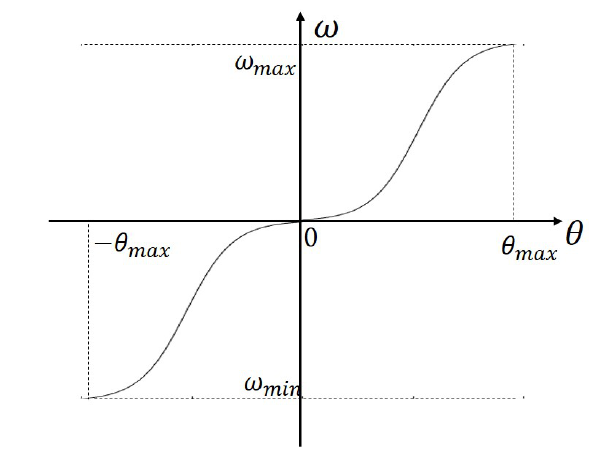
Figure 9. Relationship of Angular velocity and angle θ